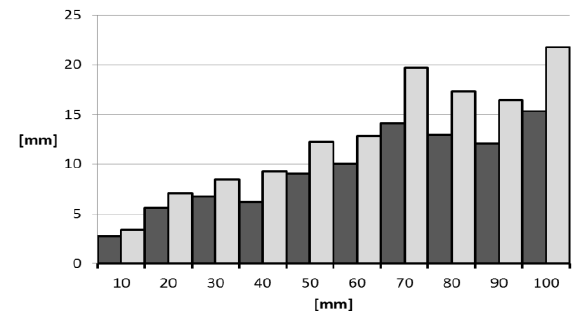
Figure 2: Influence of maximum search distance onto average deviations (dark grey) and their respective RMS (light grey) Figure 1: Colour coded visualisation of deformations: Based on reference transformation parameters and Result 2 derived by Table 4 gathers the corresponding transformation parameters for Geomagic (right) three selected settings where the first column “Res.”